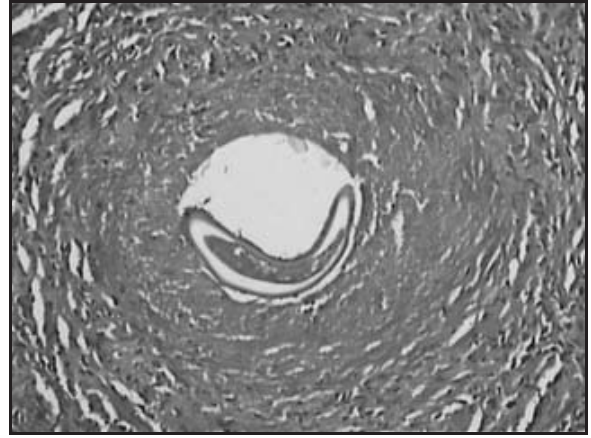
Figura 4 – Fotomicroscopia evidenciando reação granulomatosa não-necrotizante centrada por fungo (adiaconídio) no tecido pulmonar (HE,